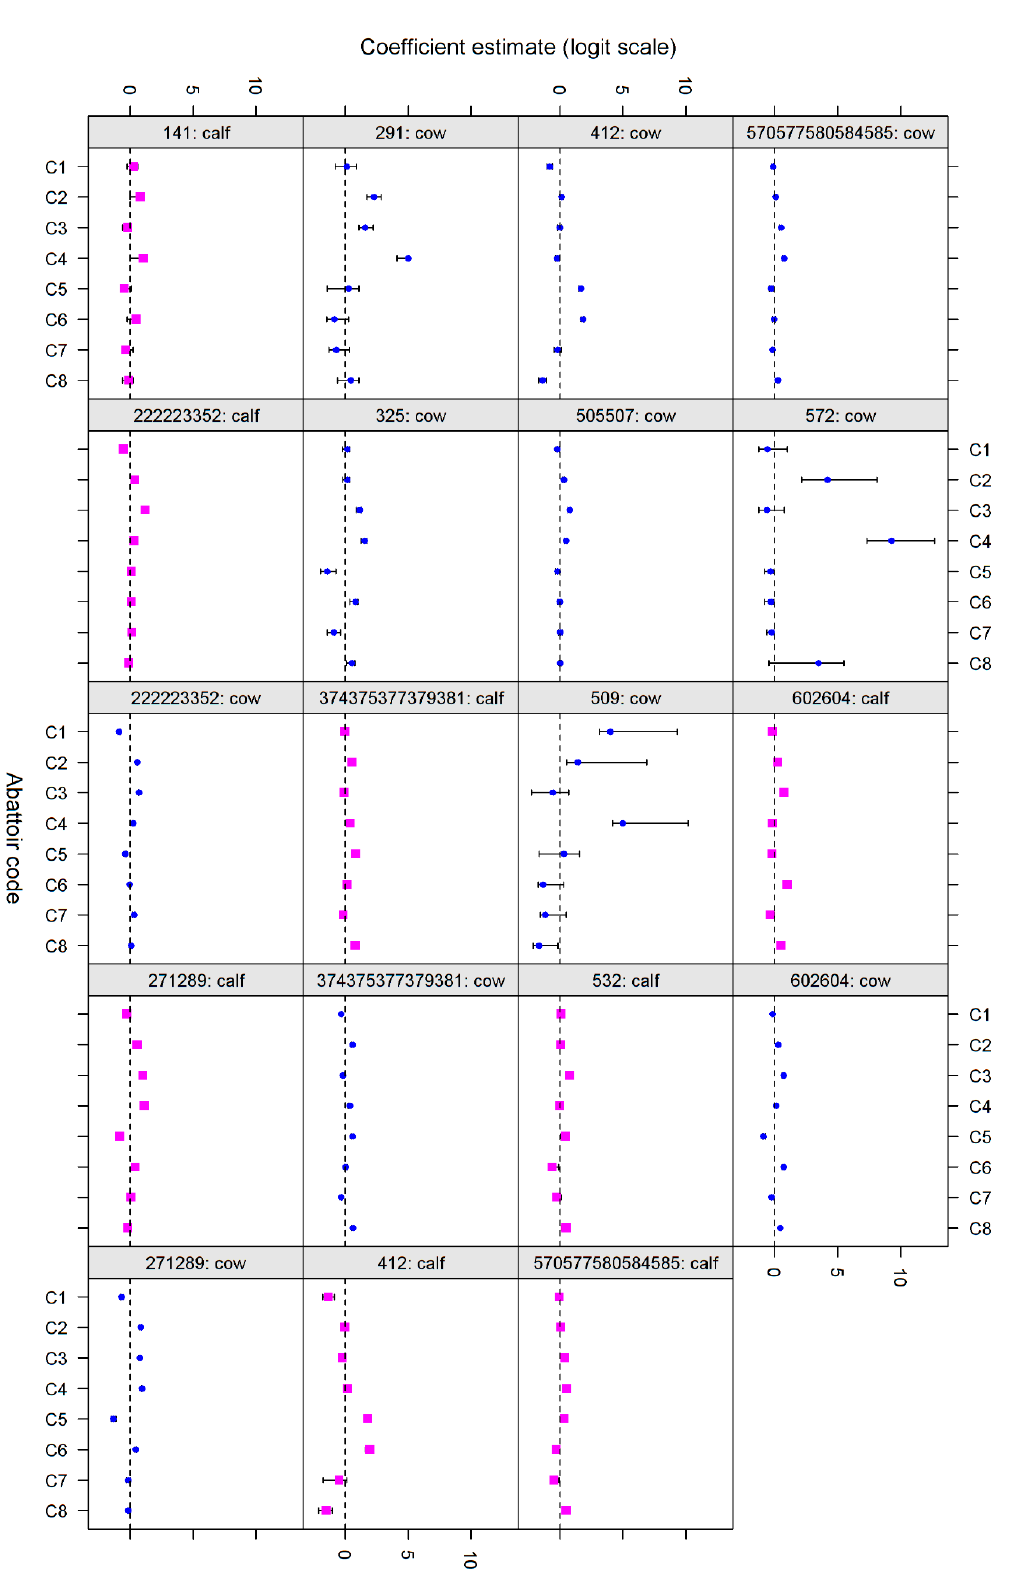
Figure 2. Individual estimates for the effect of each abattoir (95% confidence intervals shown as bars) for each code in calves (pink) and adult cattle (blue).